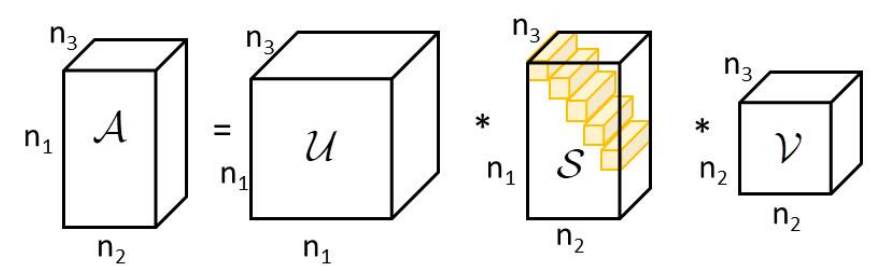
Figure 1. Schematic diagram of the singular value decomposition of the third-order tensor.